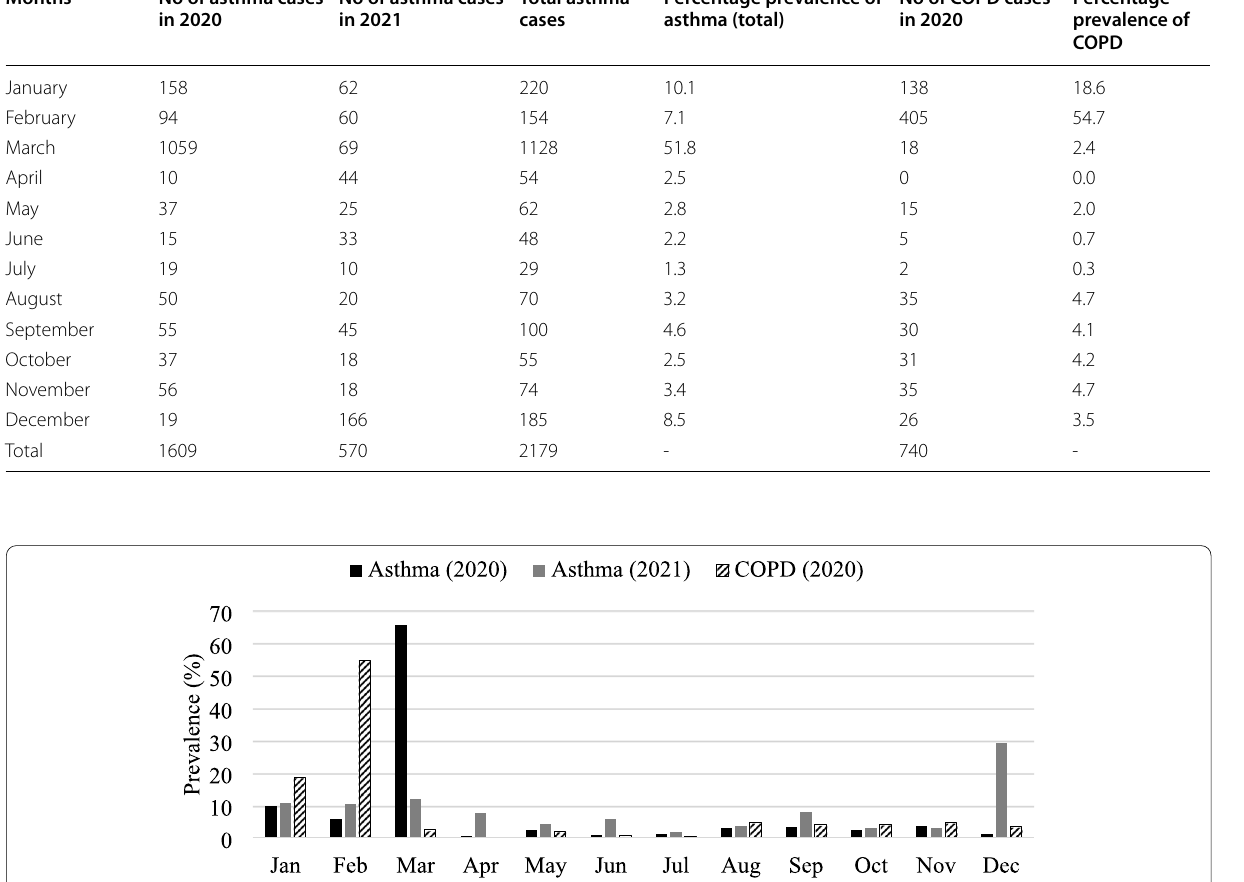
Fig. 1 Monthly percentage prevalence of asthma cases in 2020 and 2021 and chronic obstructive pulmonary disease (COPD) cases in 2020 in the District Dera Ismail